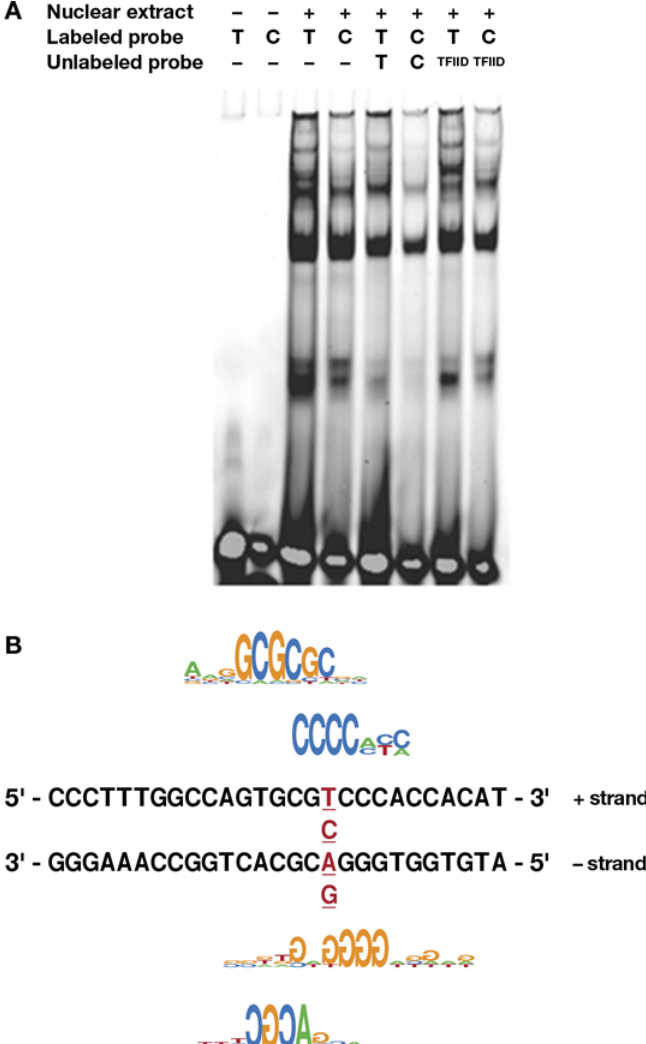
Fig 4. Allelic-specific protein binding of A3F rs5750728T/C. (A) For the EMSA, two A3F DNA fragments with rs5750728 T or C allele were incubated with HeLa nuclear extract. The specificity of the intense bands present in the rs5750728 T lane (lane 3) was demonstrated by adding 200-fold excess of unlabeled T oligo (lane 5) and unrelated TFIID oligos (lane 7) as competitors. (B) Transcription factor binding sites affected by the rs5750728 T/C change based on SNPInspector. The C allele of rs5750728 generates E2FF, ZKSCAN3 (matching the positive (+) strand of the rs5750728 residing A3F DNA fragment), KLFS and loss of WHNF (matching the negative — strand) sites. The rs5750728 site is in red and